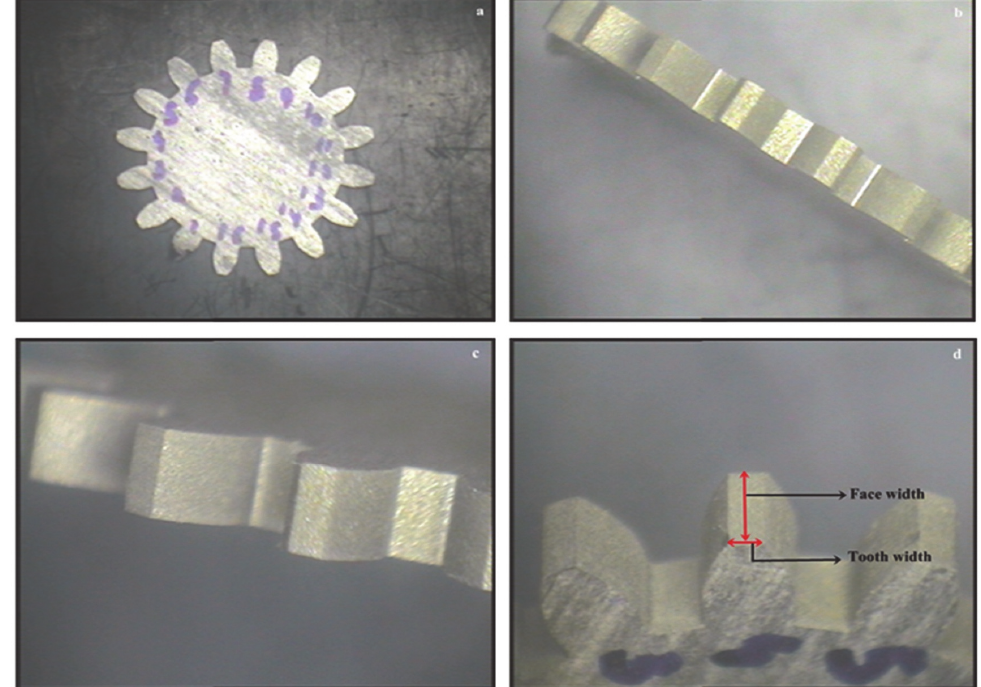
Fig. 3. Gears obtained after machining showing (a) 16 numbers of teeth, (b) top surface of the gear, (c) Side surface of the gear and (d) Nomenclature of the